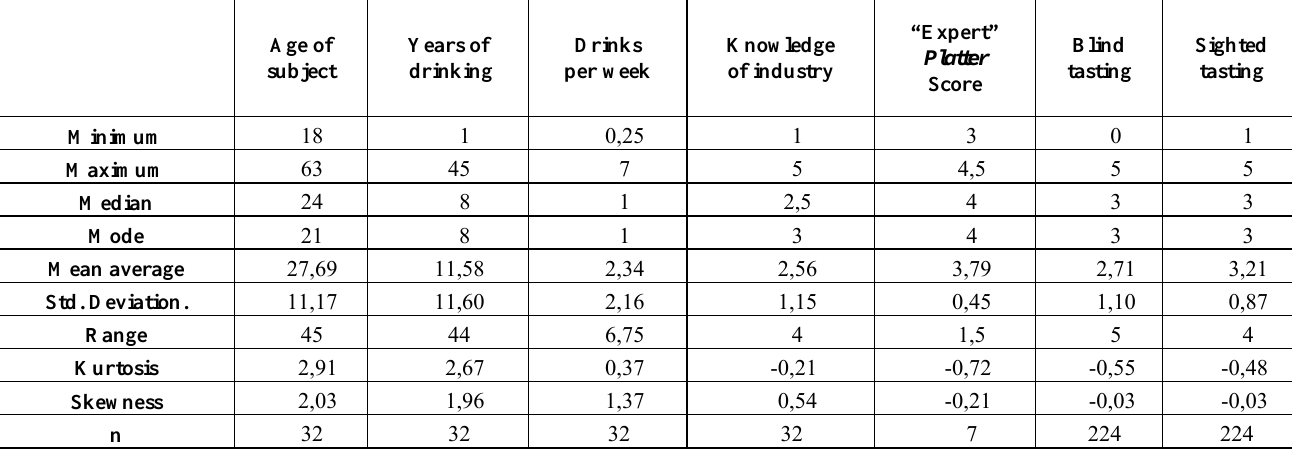
Table 2: Descriptive statistics. Note: of the 32 subjects: males = 21, females = 11.